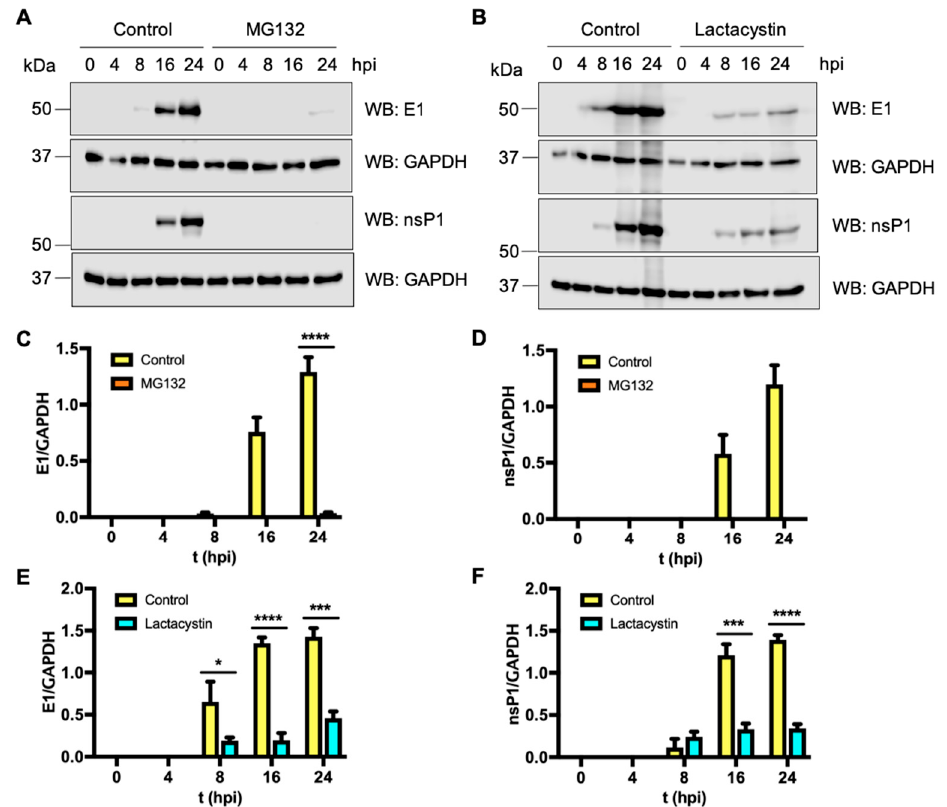
Figure 5. Proteasome inhibition diminished MAYV protein synthesis. Confluent Vero-E6 cells were pre-treated with MG132 ( A ) or Lactacystin ( B ) as described above. In control cells, DMSO (0.1%) or water was added. Cells were then infected with MAYV at an MOI of 1. At different times after infection, the levels of E1 and nsP1 proteins were evaluated by Western blot with anti-E1 and anti-nsP1 antibodies, respectively. Densitometric analysis of Western blot bands was performed using ImageJ software ( C – F ). Viral protein expression was normalized to GAPDH. Statistically significant differences are indicated: * p < 0.05; *** p < 0.001; **** p < 0.0001.